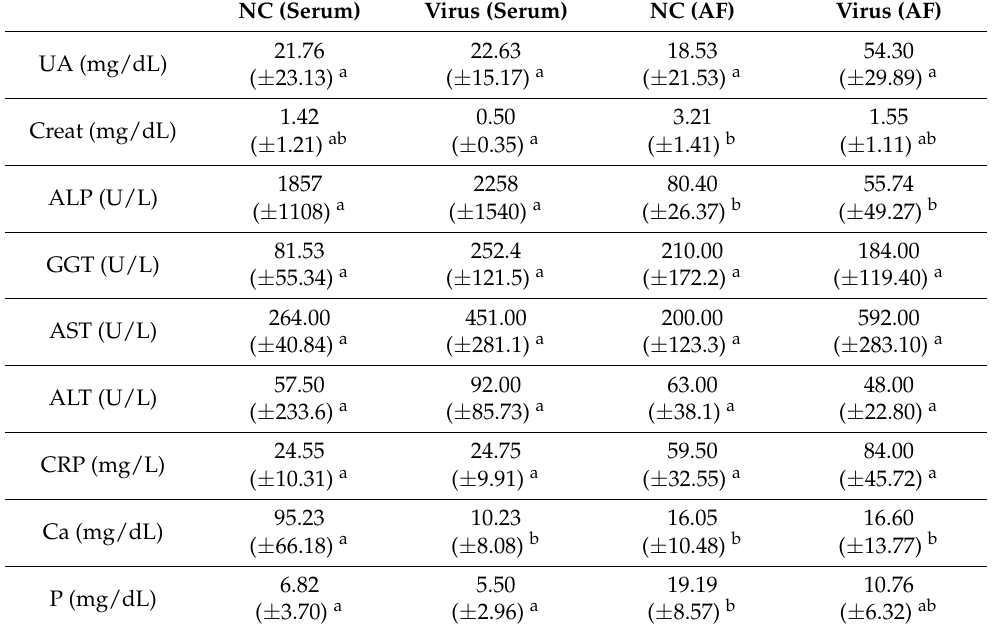
Table 2. Quantification of metabolites, minerals and enzymes in CE treated with Gammacoronavirus inoculated at 10